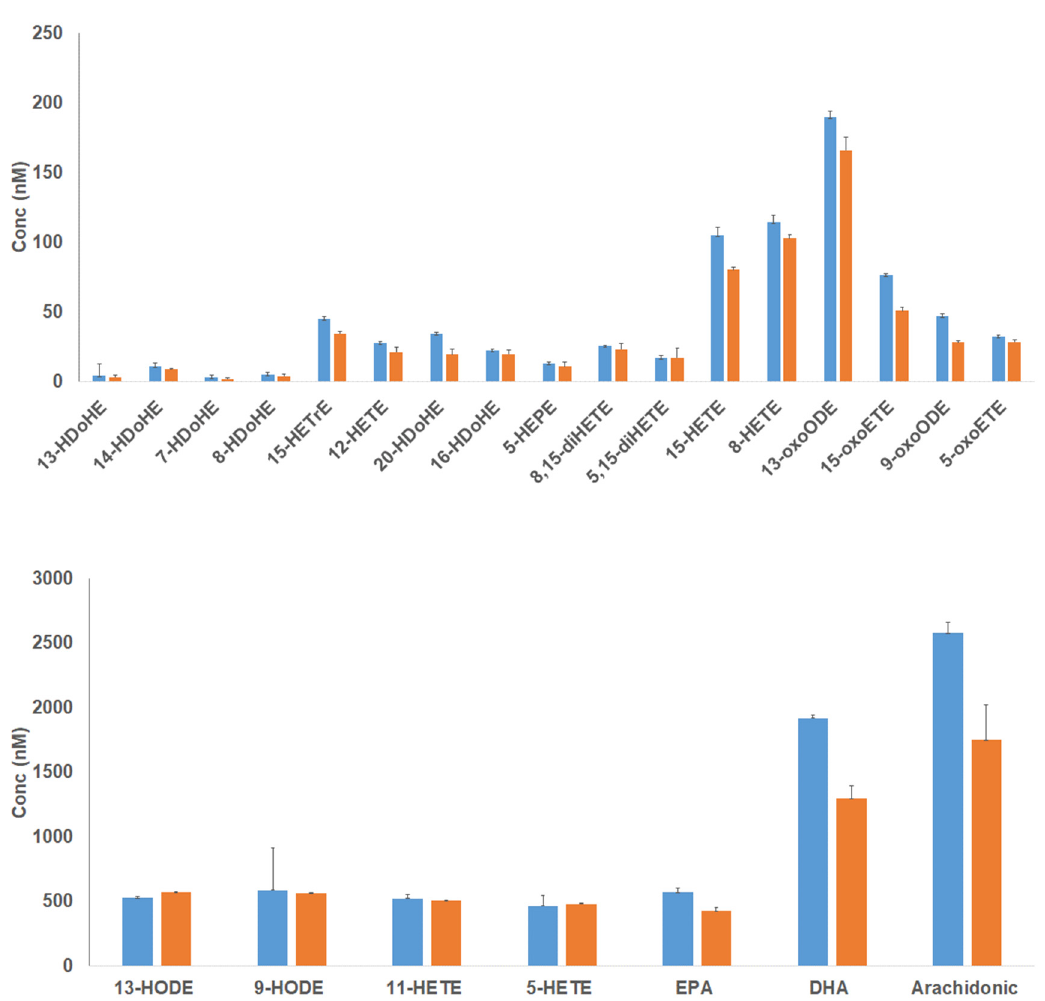
Figure 5. Comparison between the use of MIP (blue) and NIP (orange) polymers for blood plasma lipid mediators enrichment when using 0.5% acetic acid in the washing solvent. The same plasma extracts were used to test both materials. Bar charts represent Mean ±SD ( n = 3). SD—standard deviation.